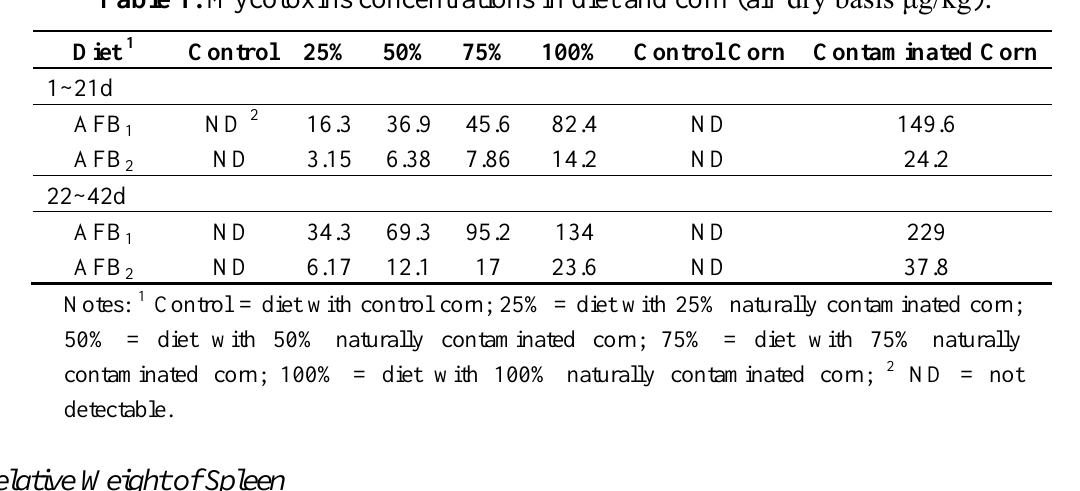
Table 1. Mycotoxins concentrations in diet and corn (air-dry basis